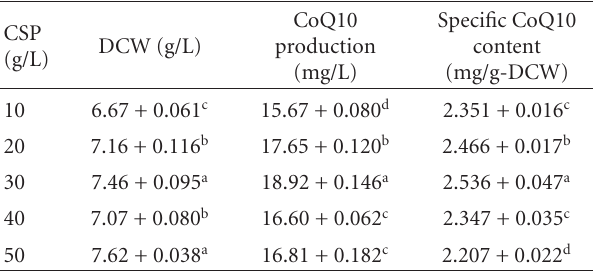
Table 4: E ff ect of CSP on DCW and CoQ10 production by PK38 with batch